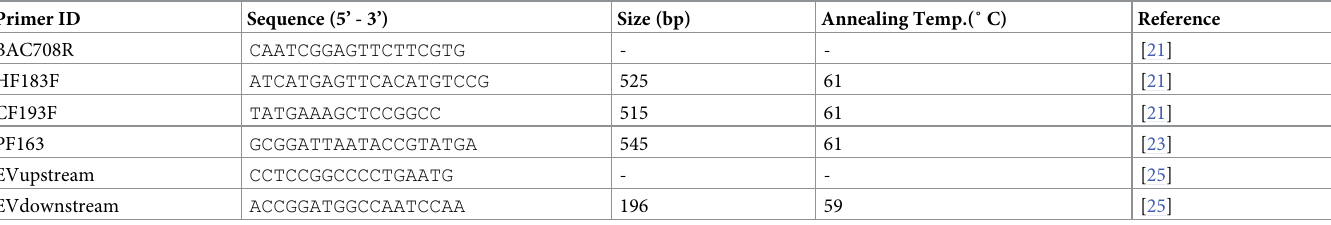
Table 2. Primer sequences for Bacteroidales host-specific fecal markers and enterovirus PCR and RT-PCR